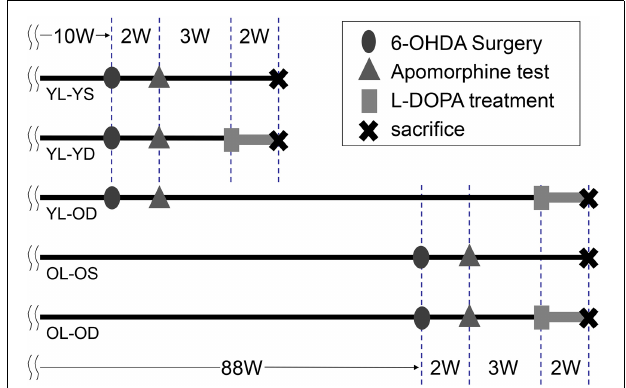
FIGURE 1 | Time chart and experimental design of the study. We performed 6-OHDA surgery to develop hemi-parkinsonian rat models at 10 or 88 weeks of age. Dopaminergic denervation was confirmed by apomorphine test. The animals were then divided into five experimental groups. Rats received either L -dopa or saline daily and were sacrificed after the last treatment. 6-OHDA, 6-hydroxydopamine; L -dopa, levo-dihydroxyphenylalanine;